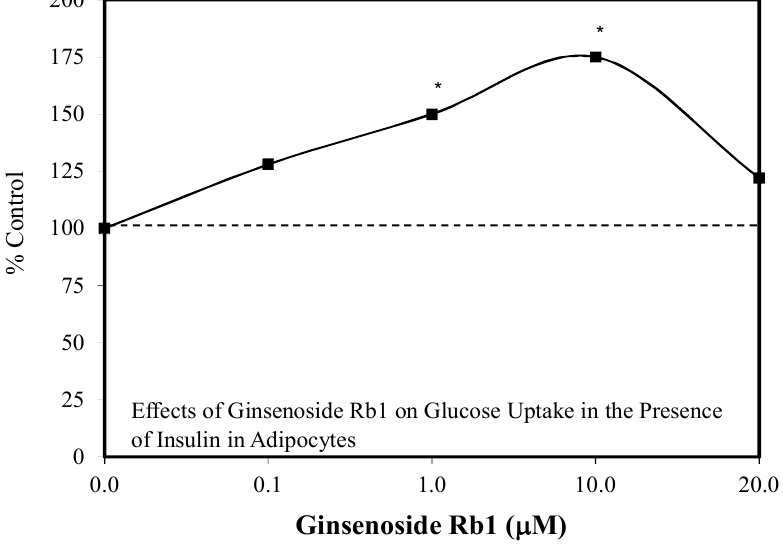
Figure 18. Effects of ginsenoside Rb1 on glucose uptake in the presence of insulin in adipocytes (source: [82]). Each * represent statistical significance for a data point.